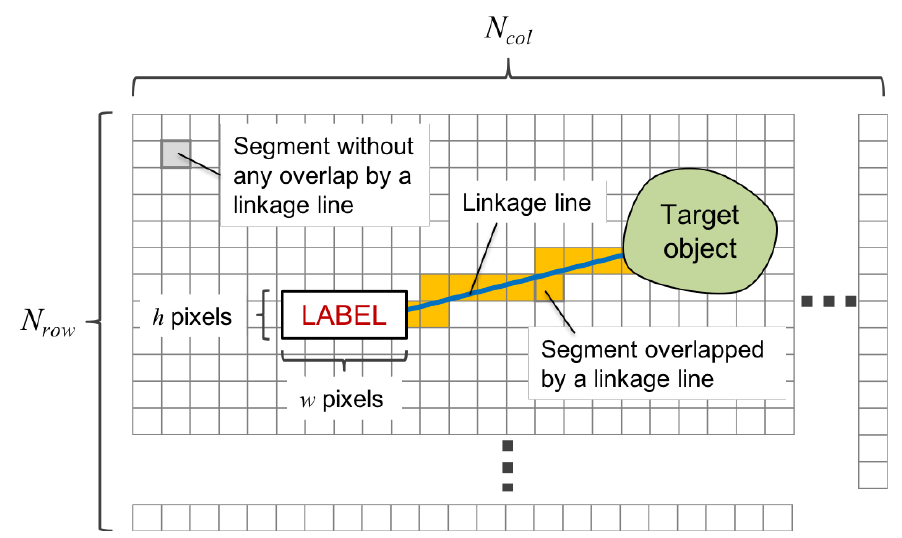
Figure 8. Definition of a region of interest (ROI) and a segment in a projection